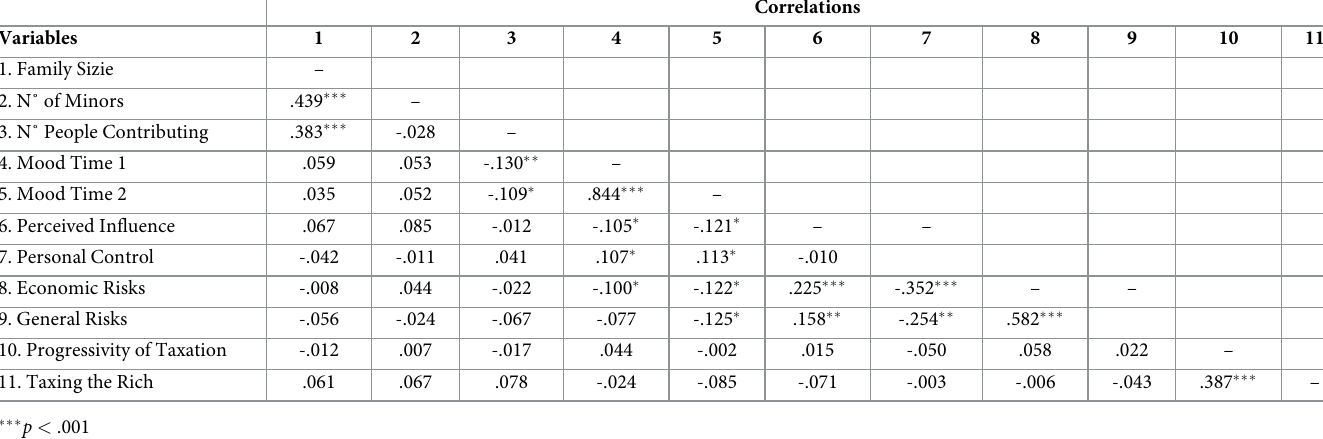
Table 3. Study 2 ( N = 384). Zero-order correlations among study variables (Family Size, Number of Minors in the Family, Number of People Contributing to the Family Income, Mood Time 1, Mood Time 2, Perceived Influence, Personal Control, Economic Risks, General Risks, Progressivity of Taxation, Taxing the